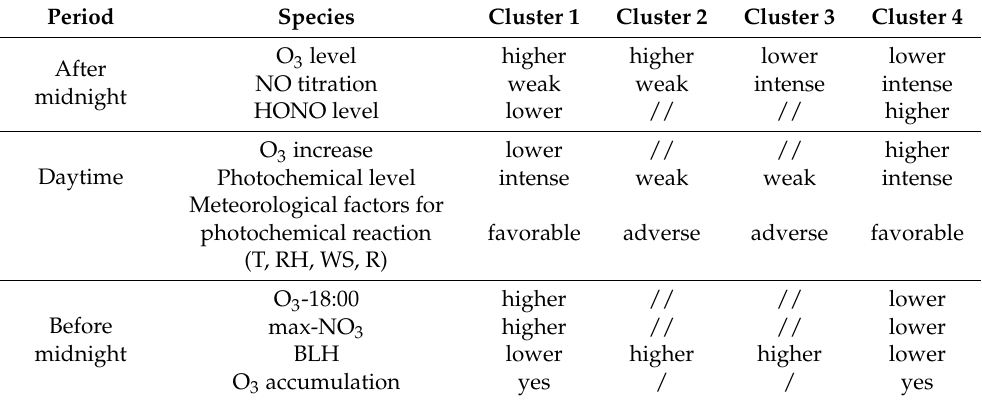
Table 1. A summary of the information visualized in Figure 6 for the four clusters in different periods. Period Species Cluster 1 Cluster 2 Cluster 3 Cluster 4 O 3 level higher higher lower lower After NO titration weak weak intense intense midnight HONO level lower // // higher O 3 increase lower // // higher Daytime Photochemical level intense weak weak intense Meteorological factors for photochemical reaction favorable adverse adverse favorable (T, RH, WS, R) O 3 -18:00 higher // // lower Before max-NO 3 higher // // midnight